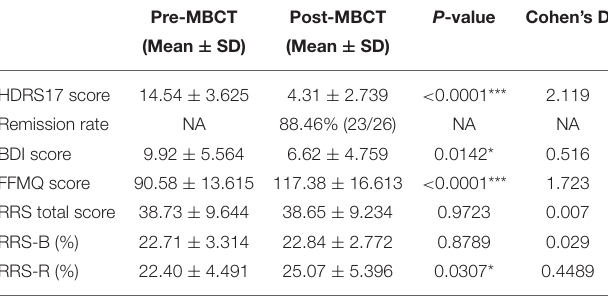
TABLE 1 | Changes in clinical and psychological